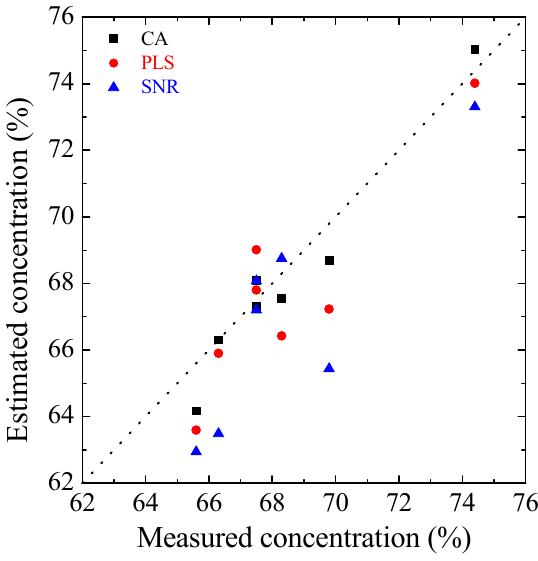
Figure 10. Estimated carbon concentrations with CA, PLS, and SNR.